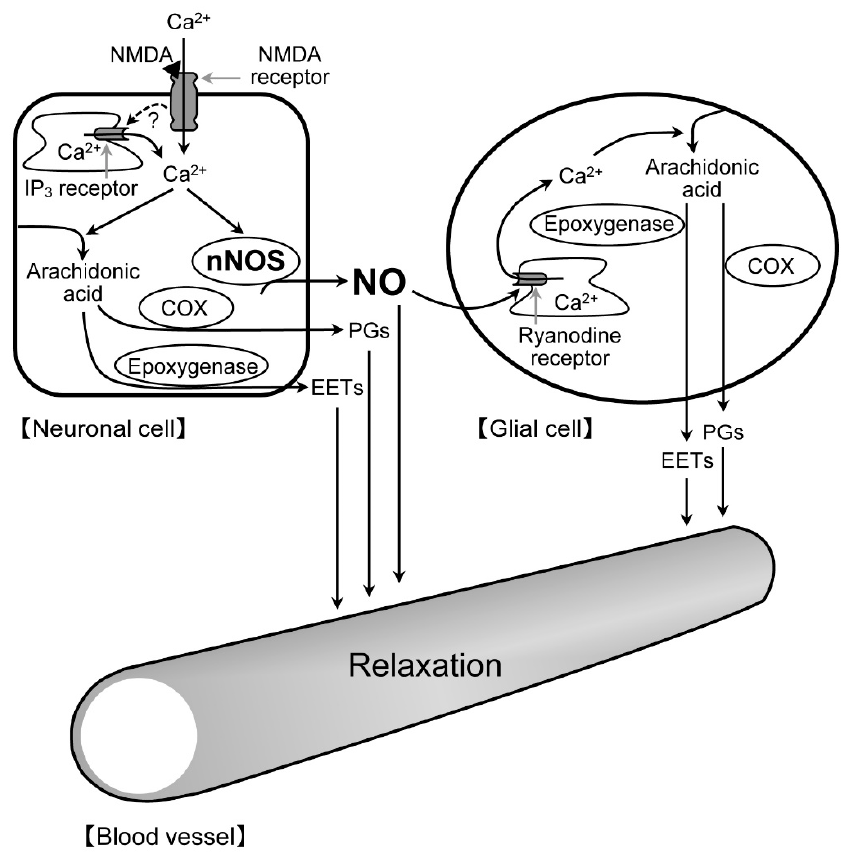
Figure 9. A putative mechanistic model for the interaction between neuronal cells and glial cells in the retinal vasodilatory mechanism. Stimulation of NMDA receptors on neuronal cells facilitates neuronal nNOS-derived NO production. The NO released from neuronal cells acts on glial cells and enhances ryanodine receptor-mediated Ca 2+ release and thereby stimulates the production of PGs and EETs in the cells. The released PGs and EETs dilate retinal blood vessels. A black triangle mark ( ▲ ) indicates NMDA. EETs, epoxyeicosatrienoic acids; NMDA, N -methyl- D -aspartic acid; NO, nitric oxide; nNOS, neuronal NO synthase; PGs, prostaglandins.